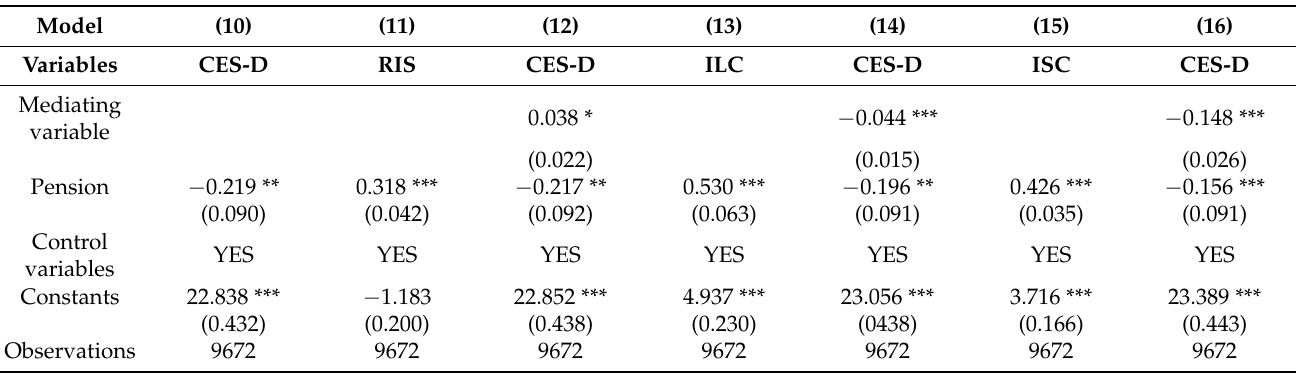
Table 4. Mechanism test